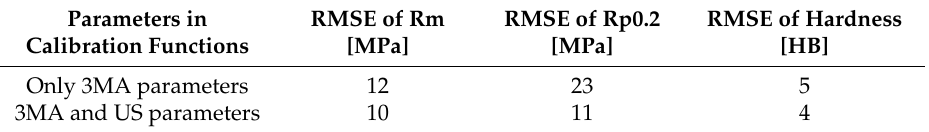
Table 9. Results of different types of calibration—without and with ultrasound (US) parameters.